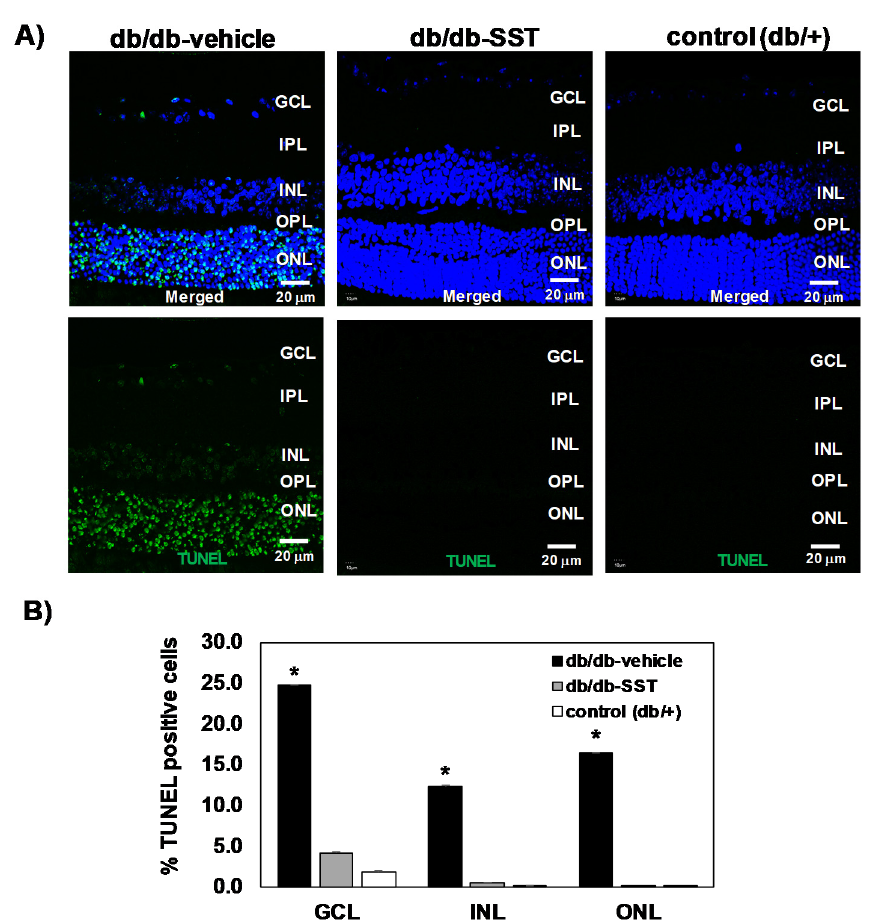
Figure 3. Effect of topical SST administration on apoptosis in retinas from db/db mice. ( A ) TUNEL-positive immunofluorescence (green) in a representative mouse from each group. Nuclei were labeled with Hoechst (blue). ONL: outer nuclear layer; INL: inner nuclear layer; GCL: ganglion cell layer. ( B ) Percentage of TUNEL-positive cells in the neuroretina. Black columns: db/db-vehicle; gray columns: db/db-SST; white columns: db/+. Results are mean ± SEM. * p < 0.01 in comparison with the other groups. N: 10 mice per group.